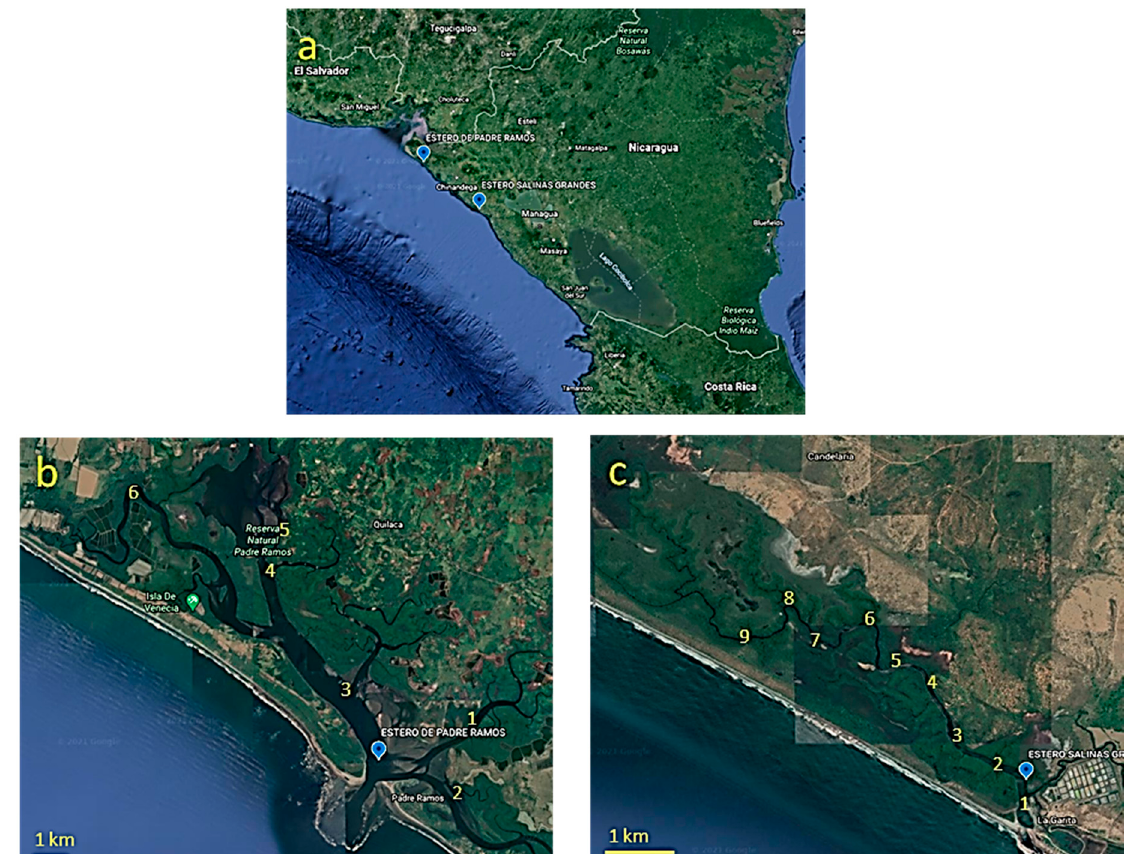
Figure 1. ( a ) Estero del Padre Ramos (EPR) and Estero Salinas Grandes (EGS), located on the Pacific coast of Nicaragua. ( b ) The six sampling sites in the Estero del Padre Ramos. ( c ) The nine sampling sites in the Estero Salinas Grandes. Sites names and their coordinates are given in Table S1 (Supplementary material). Pictures from Google Maps and Earth 2021.